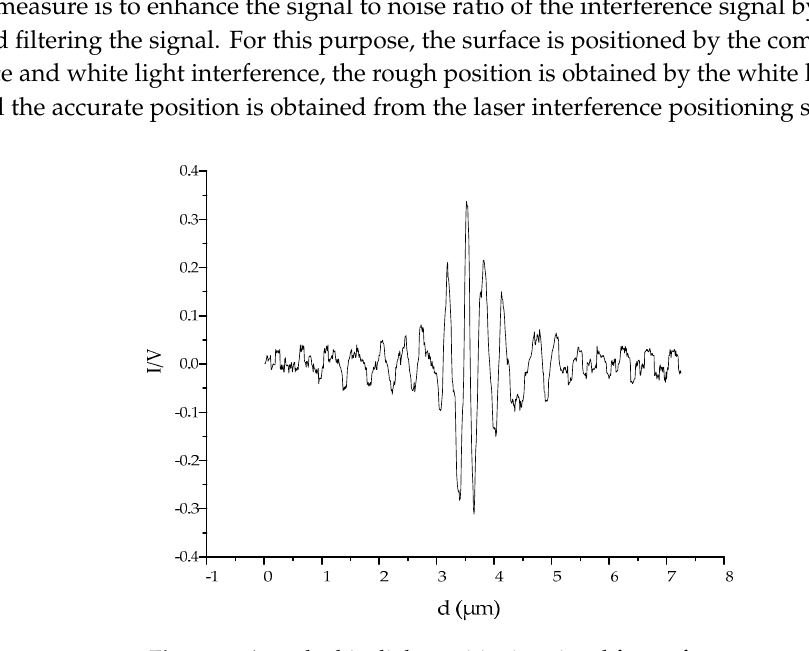
Figure 4. Actual white light positioning signal for surface.